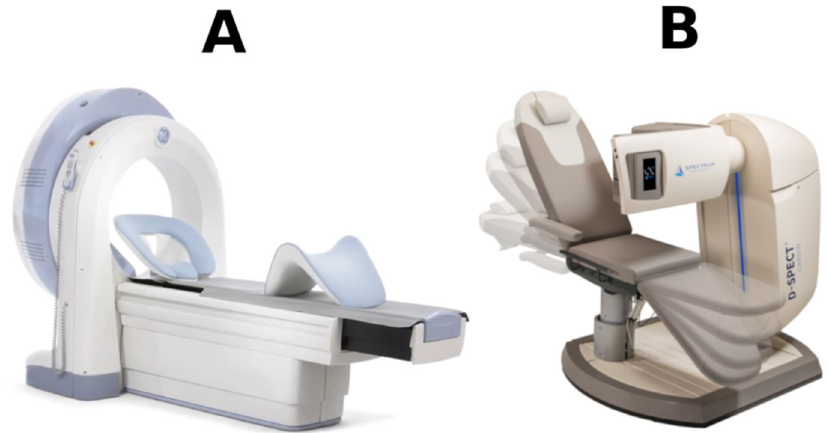
Figure 1. Cardiac—centered CZT SPECT cameras: ( A ) Discovery NM 530c by General Electric and ( B ) D-SPECT by Spectrum Dynamics.